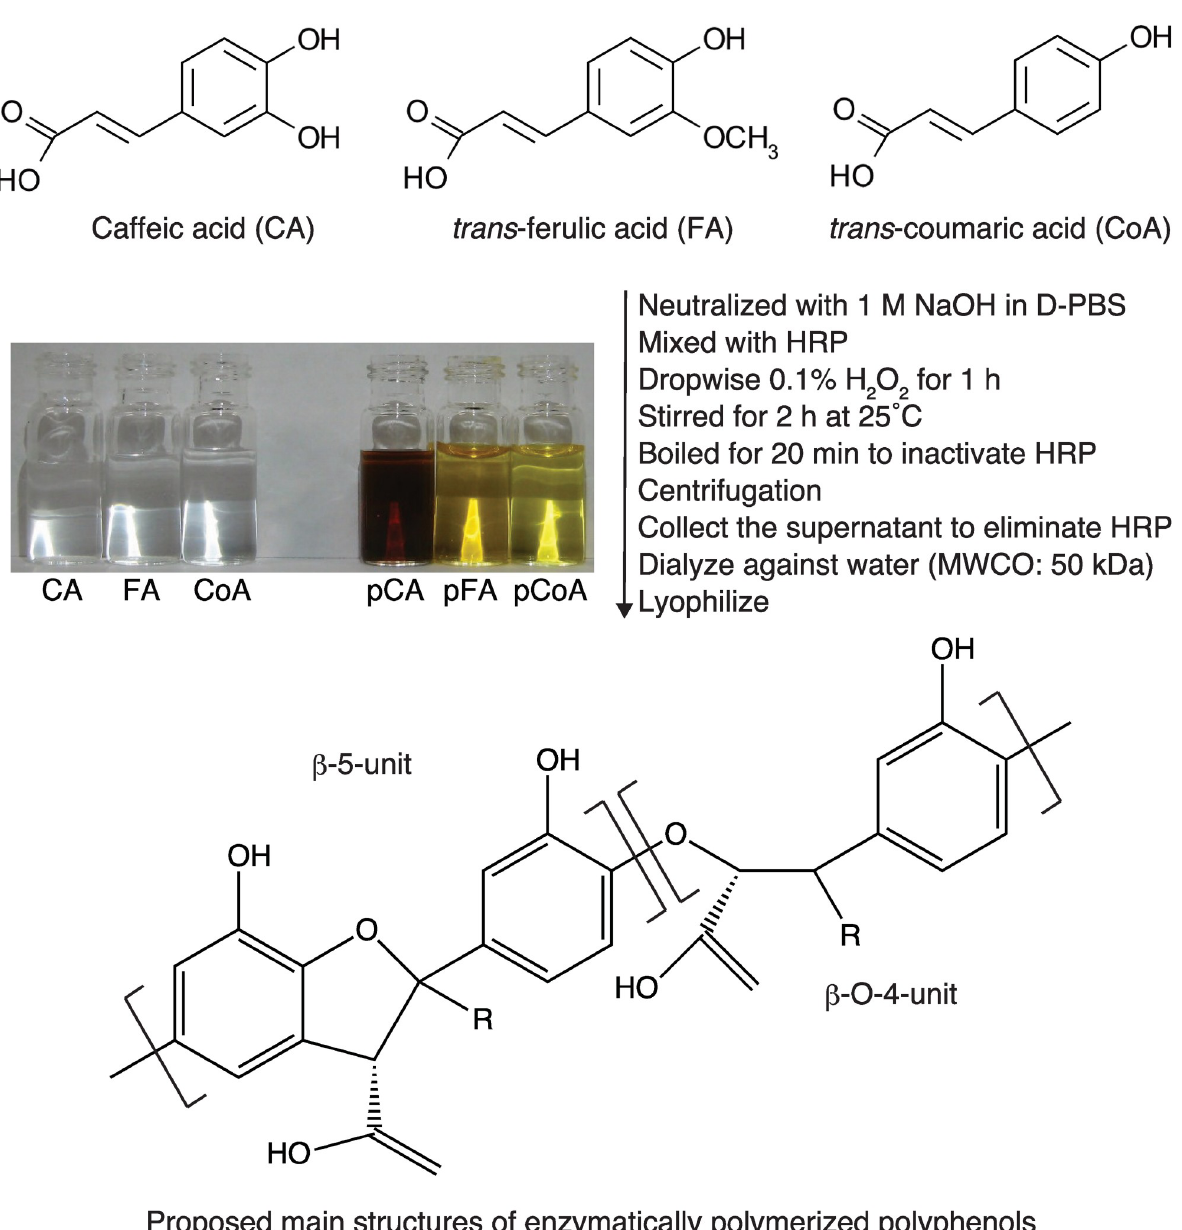
Fig 1. The scheme of synthesis, the structure of precursors, and the proposed major structure of enzymatically polymerised polyphenols used in this study. CA, caffeic acid; FA, trans -ferulic acid; CoA, trans -coumaric acid; pCA, polymerised caffeic acid; pFA, polymerised trans -ferulic acid; pCoA, polymerised trans -coumaric acid; HRP, horseradish peroxidase; MWCO, molecular weight cut-off; R, H or OH.